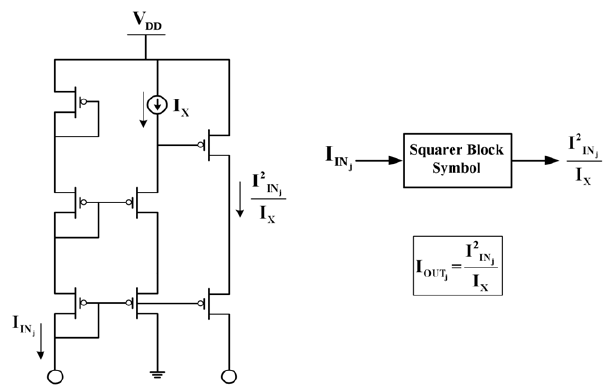
Figure 3. Schematic and symbolic representation of the squarer TL block. All devices have the same W/L ratio.